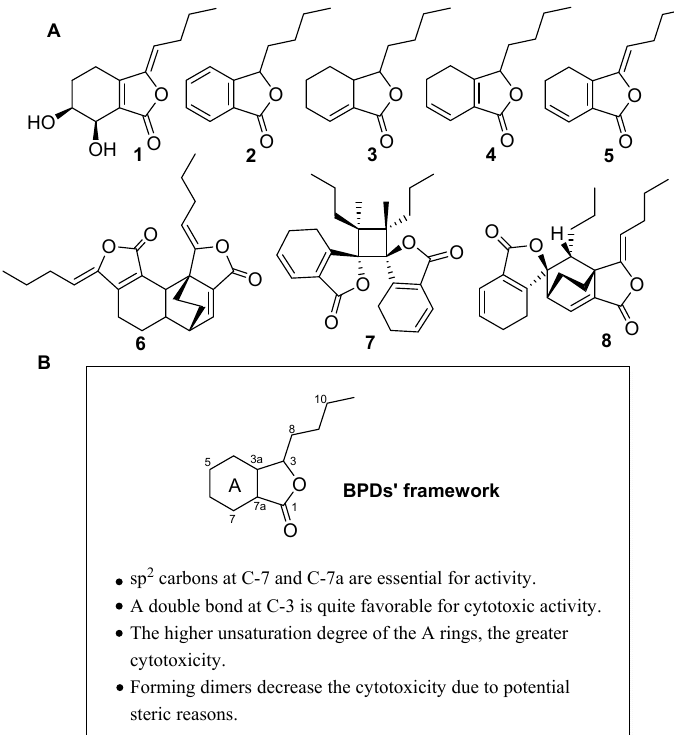
Figure 1. SAR analysis of the BPDs 1 – 8 from L. chuanxiong . ( A ) The structures of BPDs 1 – 8 ; ( B ) SAR of BPDs 1 – 8 . BPDs 1 – 8